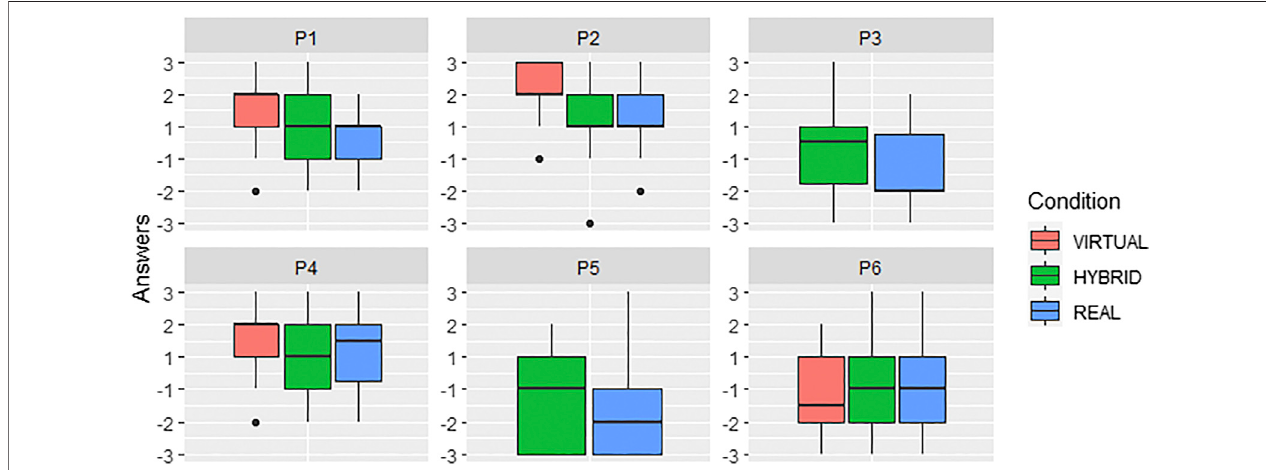
FIGURE6| Boxplotsofthepost-experimentquestionnaireanswers,evaluatedona6-point(forced)Likertscale.Answerswerecodedfrom − 3( “ stronglydisagree ” ) to + 3 ( “ strongly agree ” ).